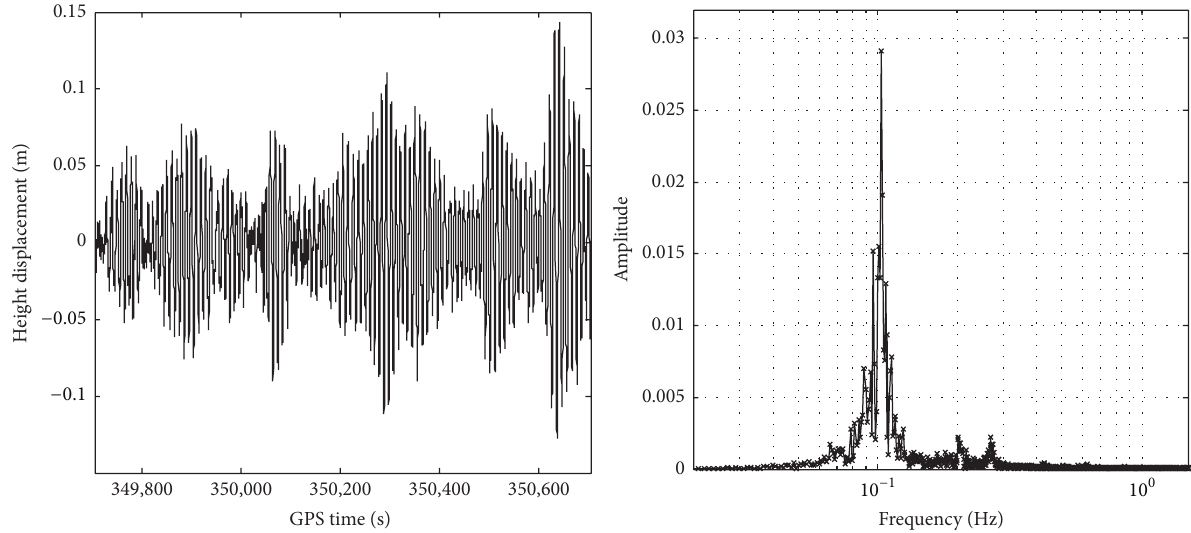
Figure 25: The filtered height displacements and corresponding